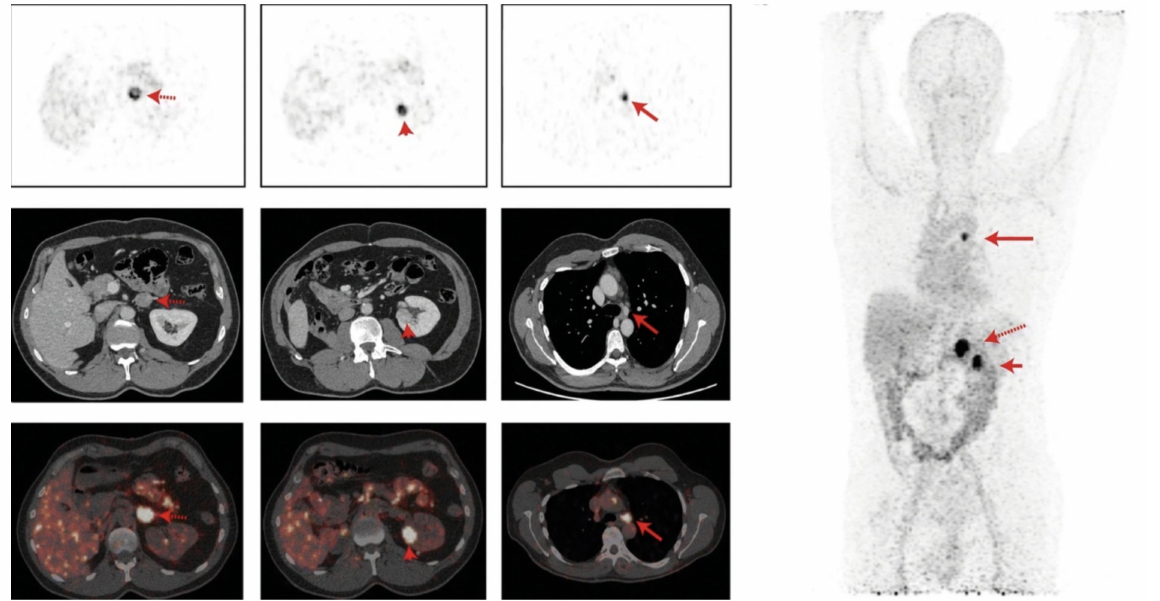
Figure 2. 89 Zr-girentuximab in renal cancer patient. Left panel: top row, axial PET imaging at 168 h post administration (h p.a).; middle row, contrast enhanced CT; bottom row, fused PET/CT imaging showing (from left to right) 89 Zr-girentuximab uptake in the adrenal gland (red arrow), left kidney (red arrowhead), and mediastinal lymph node (red arrow). Right panel: the maximum intensity projection (MIP) whole-body PET image at 168 h p.a. Reprinted with permission from Merkx, R.I.J.; Lobeek, D.; Konijnenberg, M.; et al. Phase I study to assess safety, biodistribution, and radiation dosimetry for 89 Zr-girentuximab in patients with renal cell carcinoma. Eur J Nucl Med Mol Imaging, 2021. 48, 3277–3285